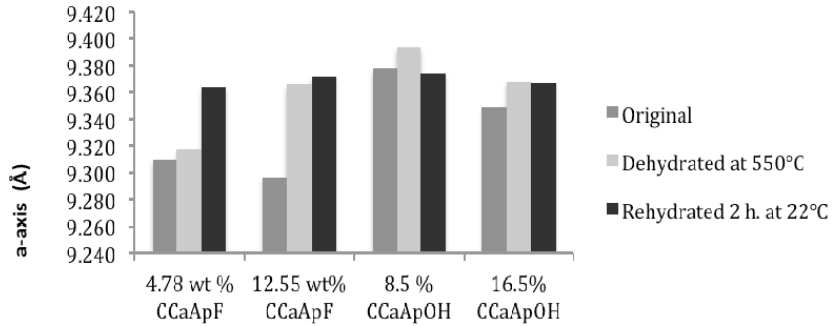
Figure 12. Variation in a-axis length for two fluor- and two hydroxylapatites, showing the effect of dehydration and rehydration.